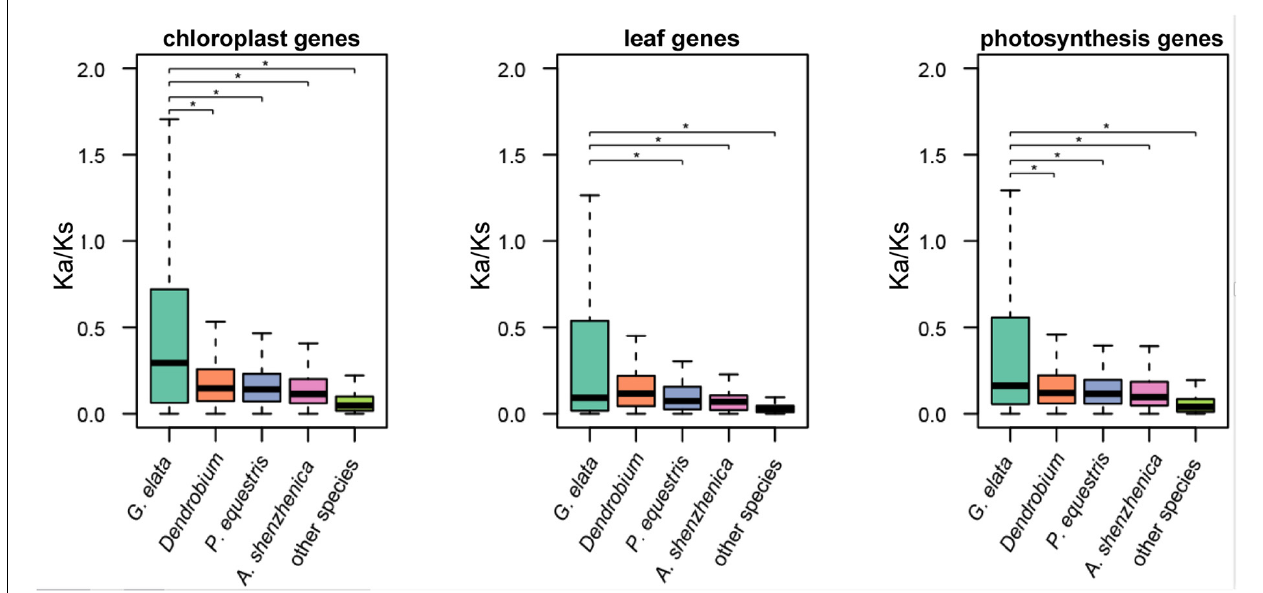
FIGURE 3 | Relaxation of selective constraints on nuclear-encoded genes. K a / K s ratios of nuclear-encoded plastid genes and genes involved in leaf development in G. elata , other orchids (including D. officinale , P. equestris , D. catenatum, and A. shenzhenica ) and other green plants (including A. thaliana and O. sativa ). * P <